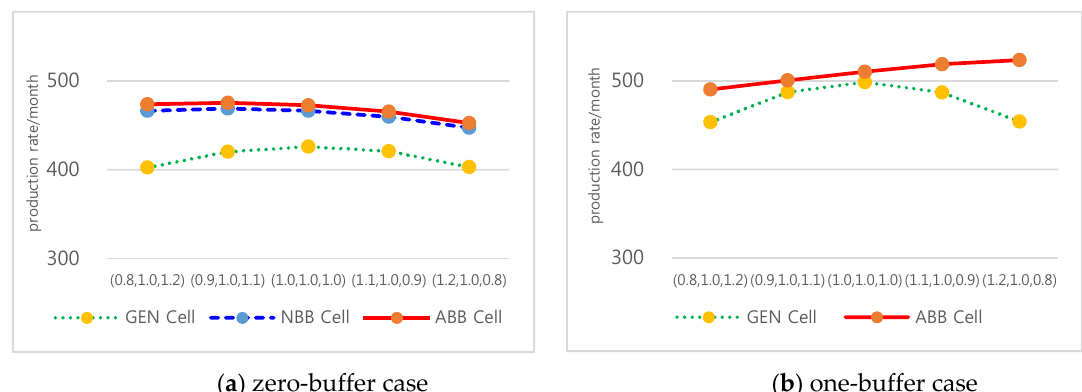
Figure 10. Performance of assembly systems over different work speeds with ( a ) buffer size of zero and ( b ) buffer size of one. The notation at the x -axis, ( s 1, s 2, s 3) indicates that the work speeds are s 1, s 2, and s 3 for the first, second, and third workers, respectively.